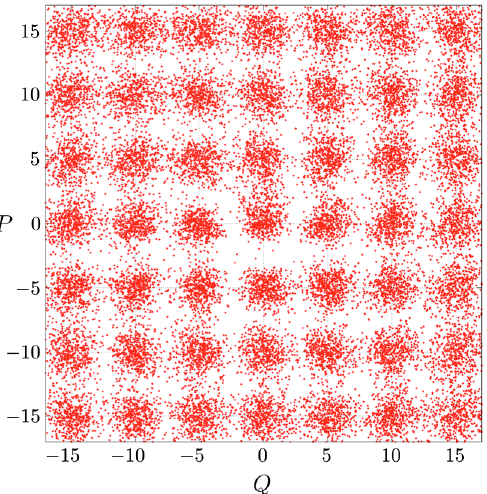
FIG. 6. The phase-space representation of reconstructed signal pulses after phase-drift compensation.